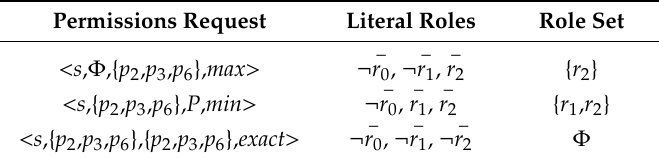
Table 5. Activated